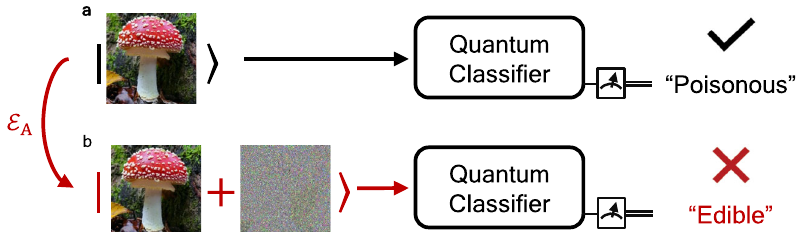
Fig. 1 Adversarial attack. a A quantum classi fi er correctly classi fi es the (toxic) mushroom as “ poisonous ” . b An adversary perturbs the image to fool the classi fi er into believing that the mushroom is “ edible ”